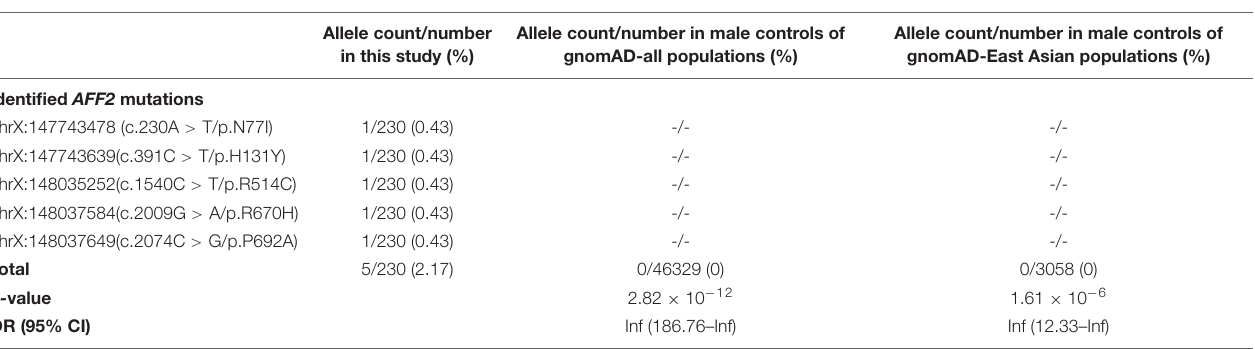
TABLE 2 | Analysis of the aggregate frequency of AFF2 mutations identified in this study.